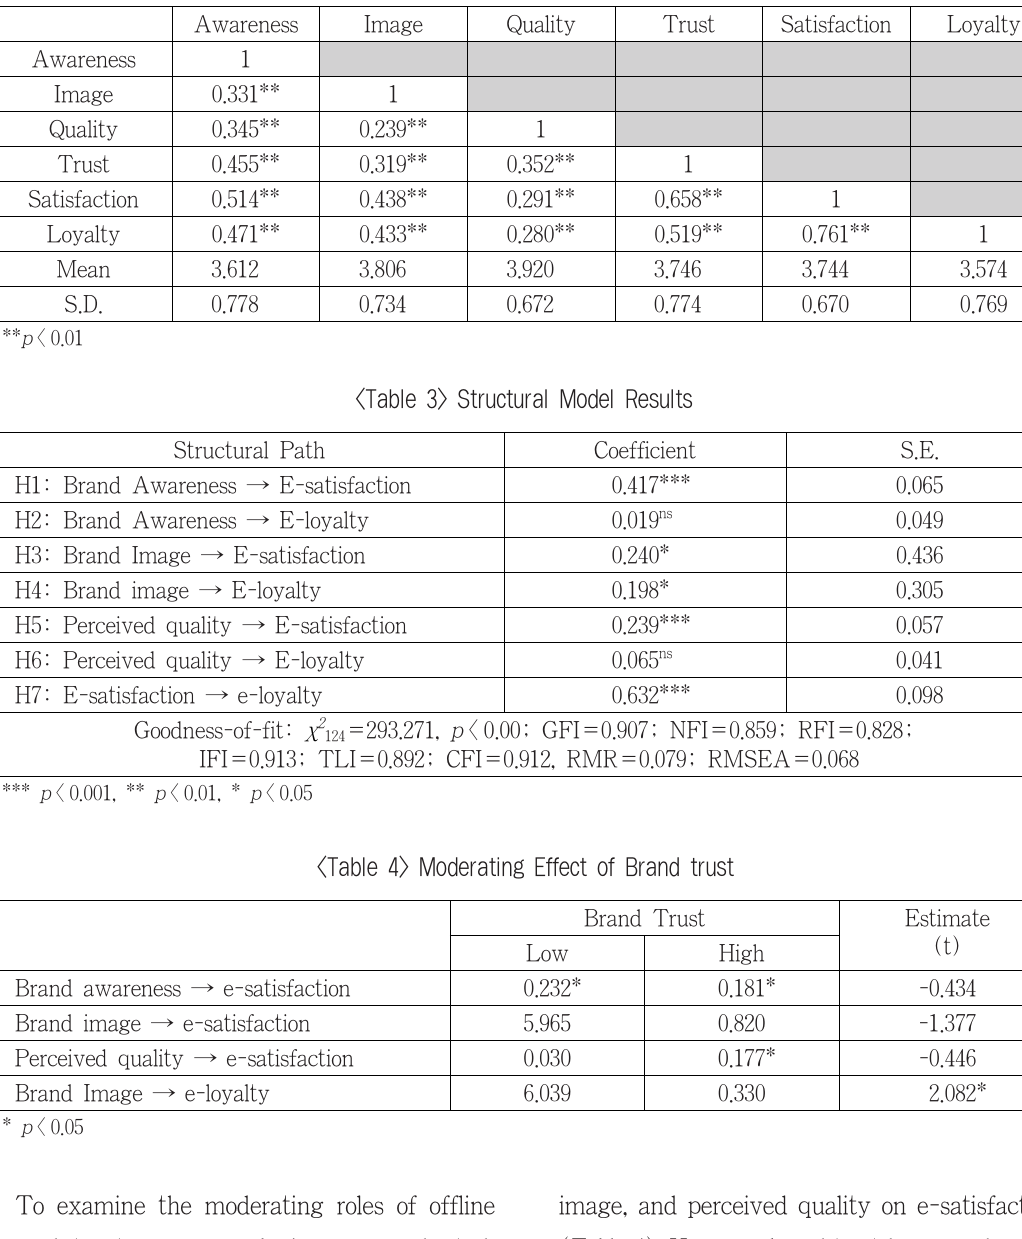
<Table 2> Construct Means, Standard Deviations, and Correlations